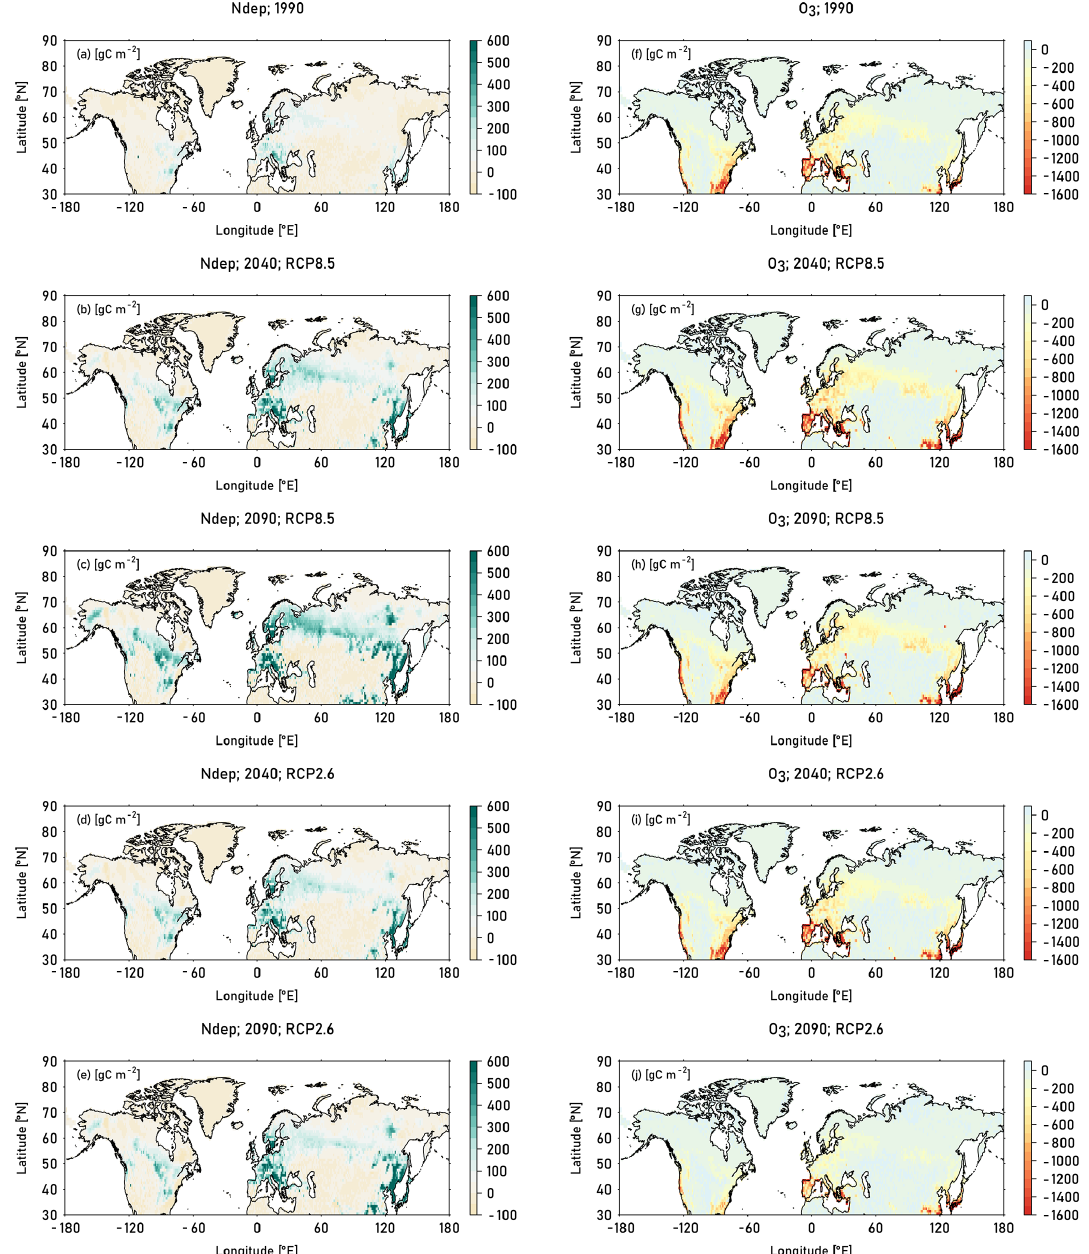
Figure 10. Absolute change in the total carbon biomass in vegetation (vegetation C) compared to preindustrial values induced by nitrogen deposition (left column) and O 3 calculated according to approach 2 (right column). The induced change in the total carbon biomass is displayed for the decades 1990 (mean of the years 1990–1999), 2040 (mean of the years 2040–2049), and 2090 (mean of the years 2090– 2099). For the decades 2040 and 2090, results from simulations based on RCP8.5 and RCP2.6 are displayed. See Table 2 for details on the calculation of the single